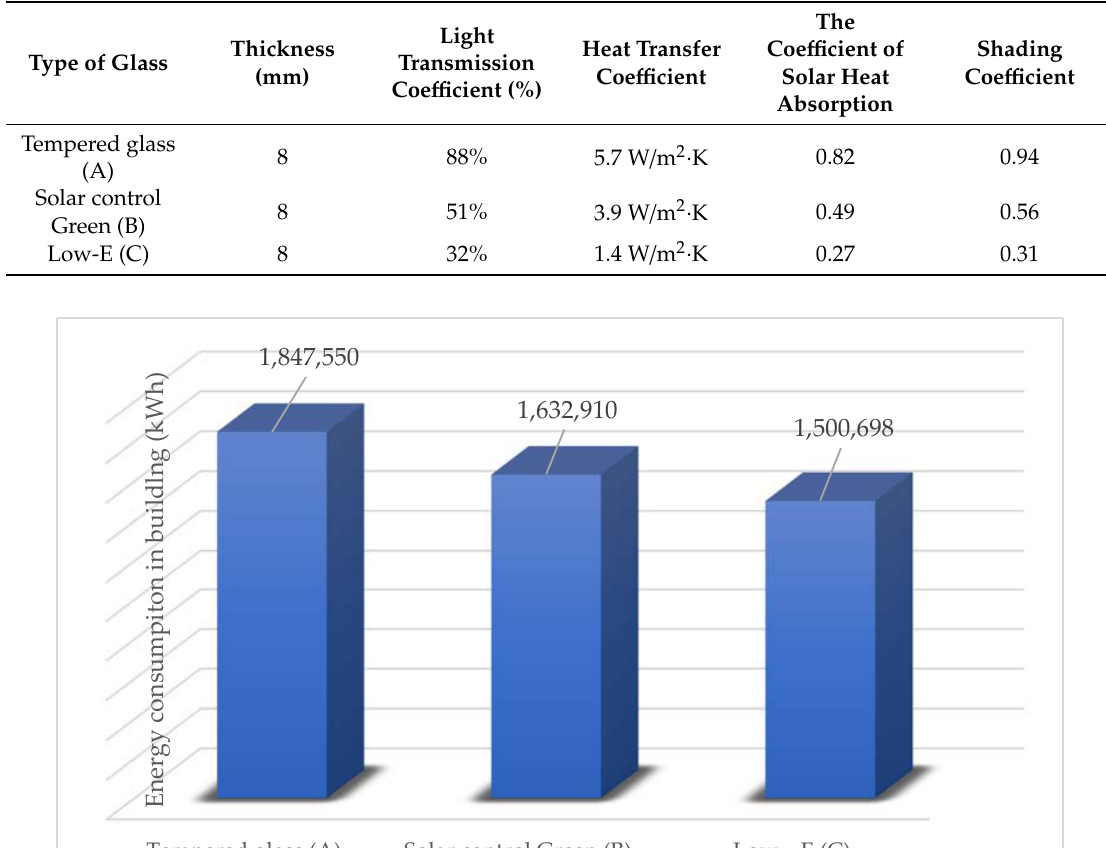
Table 5. Main specifications of the three types of glasses.